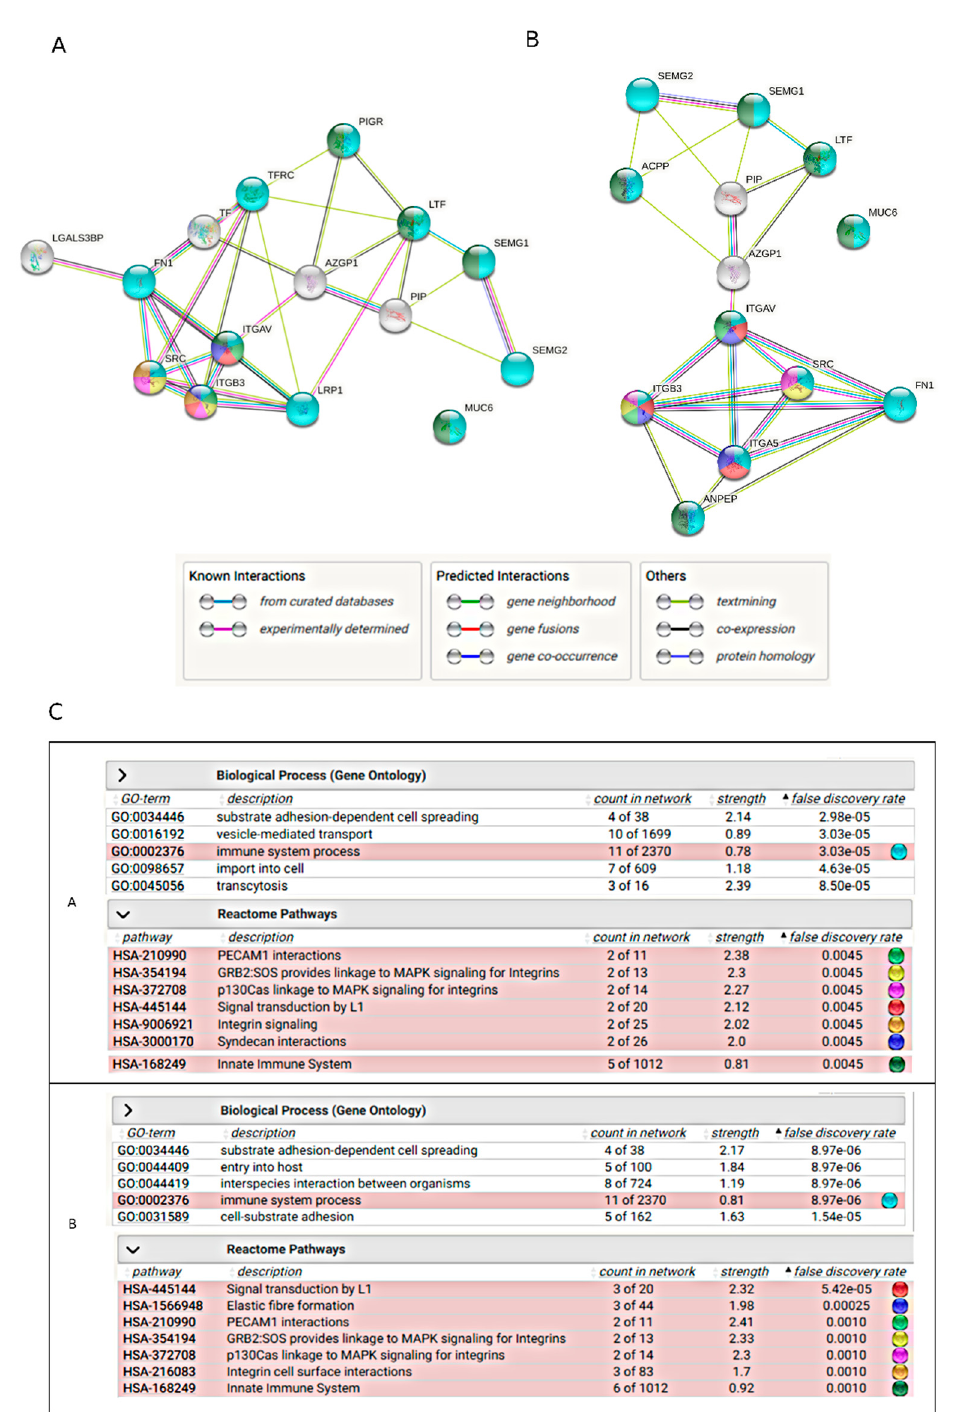
Figure 6. STRING analysis of the networks of glycoproteins identified as carriers of Gal and GalNAc epitopes. ( A )—glycoproteins identified in SDS-PAGE bands; ( B )—glycoproteins identified in affin- ity chromatography isolates, ( C ) —STRING report of the functional enrichment analysis for gene ontology and reactome pathways.